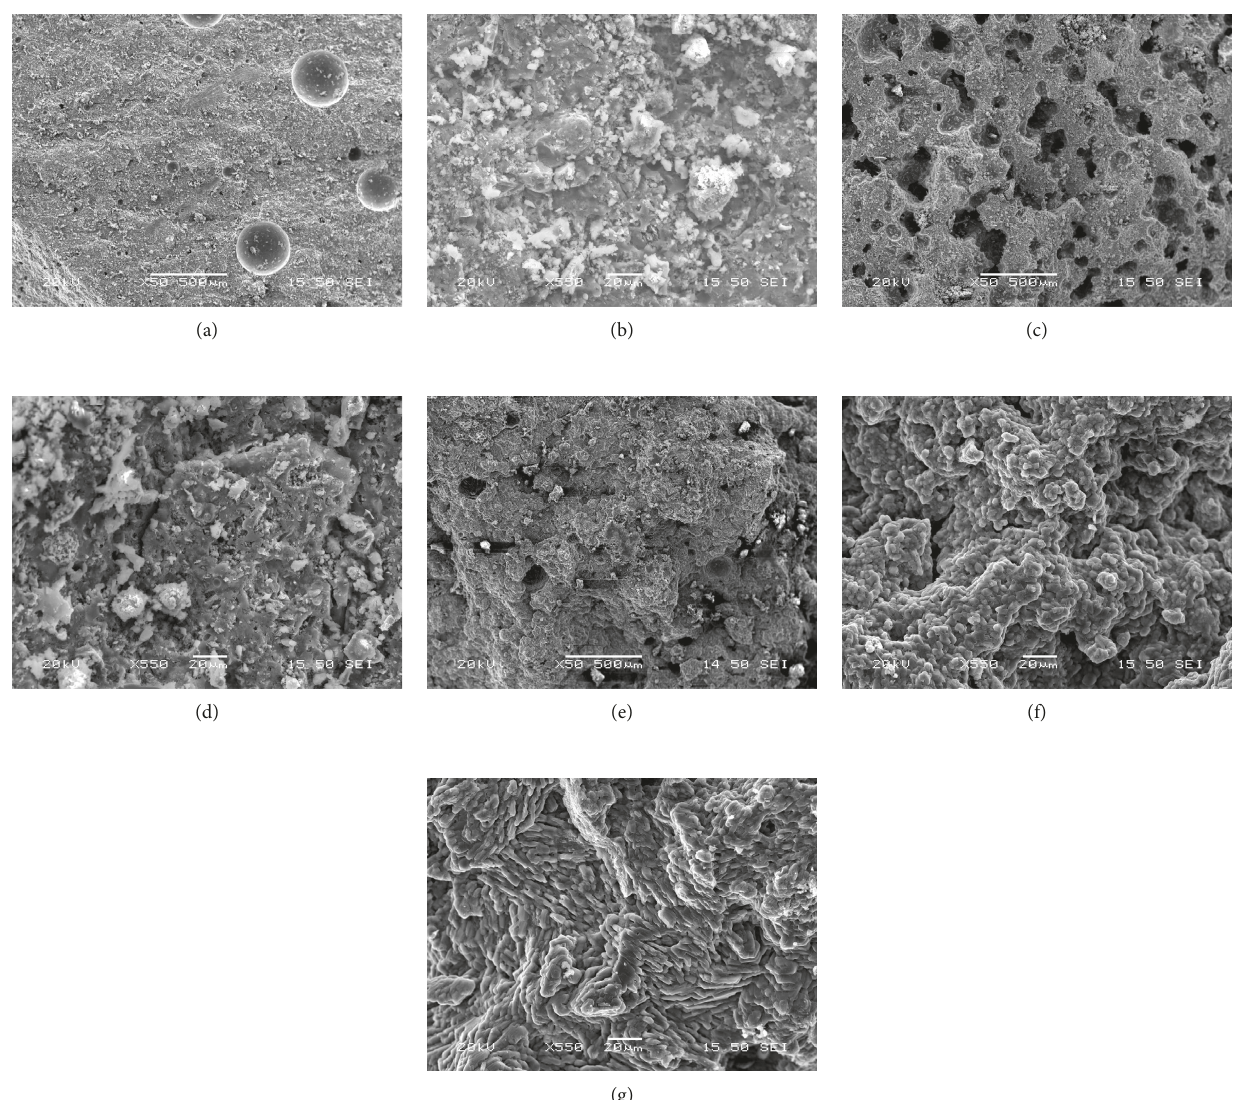
Figure 4: SEM images of selected geopolymer samples. (a, b) Reference geopolymer; (c, d) exp. 1; (e, f, g) exp.